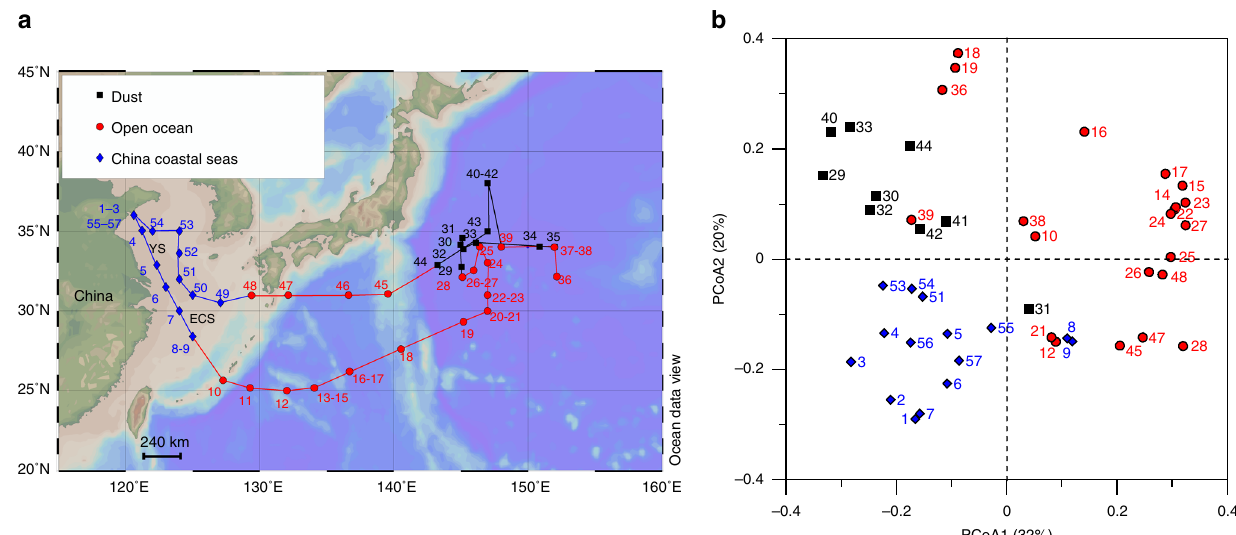
Fig. 1 Sampling map and the result of principal coordinates analysis. a Sampling map. Samples were classi fi ed according to the sampling locations, satellite images and backward trajectories (Supplementary Figs. 1 and 2). b Principal coordinates analysis (PCoA) based on the Bray – Curtis dissimilarity distance calculated from the intensity normalized molecular composition of each sample. The values of the Bray – Curtis dissimilarity (which ranges from 0, meaning completely identical, to 1, meaning completely different) for the samples ranged from 0.12 to 0.74. The largest difference was found between the dust and the open ocean aerosols. Sample groups classi fi ed by their locations and backward trajectories were highly consistent with PCoA clusters, with only a few exceptions (Fig. 1b; Methods). YS Yellow Sea, ECS East China